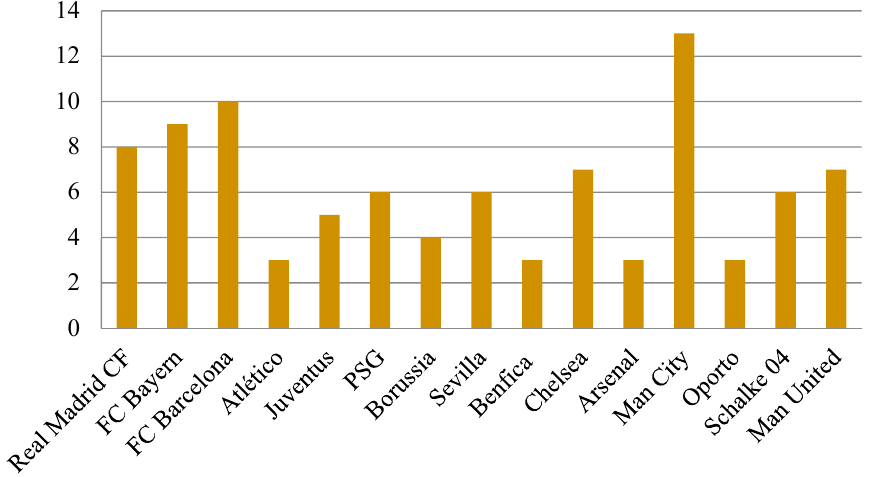
Figure 1. Number of languages available in the webpages . Source : Elaborated by the authors.